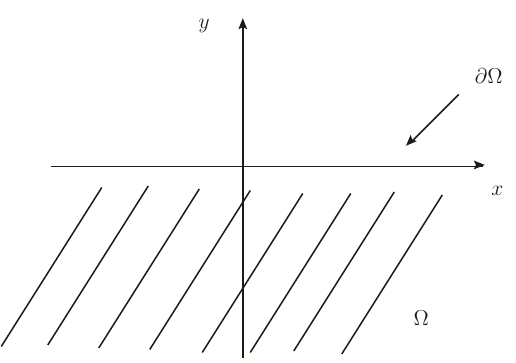
Figure 5 . Manifold with a boundary at y =